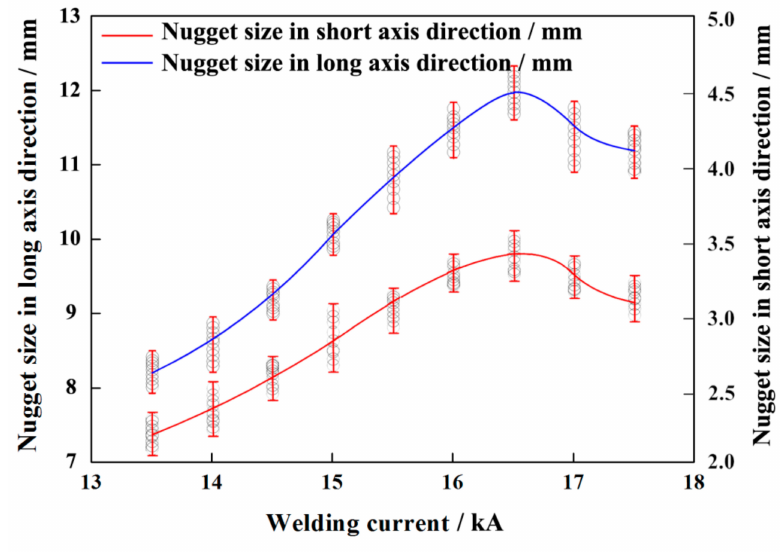
Figure 7. Influence of welding current on the dimensions of